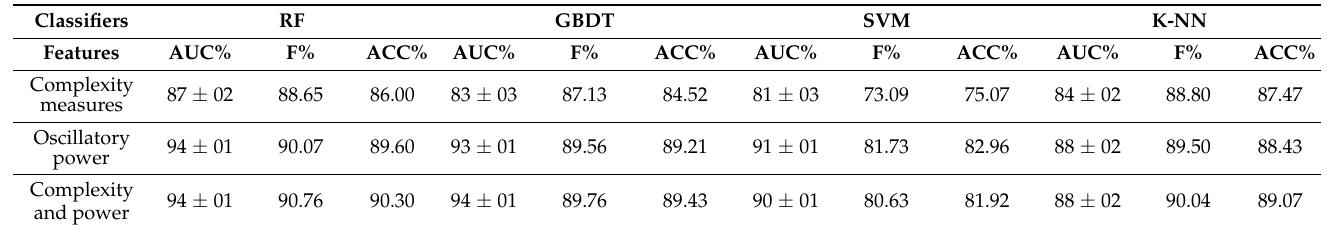
Table 6. Classification performance for the complexity measures, oscillatory power, and a combination of the two with the univariate feature selection.